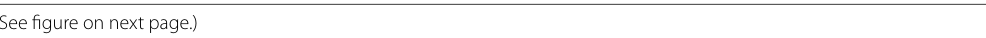
deposit(See figure on next Fig. 7 Sediment-core stratigraphy and age-depth model of core THU18-Ku-3. The sedimentological details of the MMDs are shown in zooms 1–3. The position of the radiocarbon ages is marked with a red star and the respective sample number (Table 1). The position of the historical time markers is highlighted with an arrow and the year. The age-depth model is shown in the middle part of the figure: with the calibrated 14 C ages in blue, the grey pointed lines delimiting the grey envelope represent the 95% confidence interval of the ages while the red curve represents the “best” model based on the weighted mean age of each depth. The dashed grey curve represents the sedimentation rate in cm/year. The 14 C age distribution of selected depths are also displayed. The red bars mark the 95% confidence interval. MMD: Mass-movement